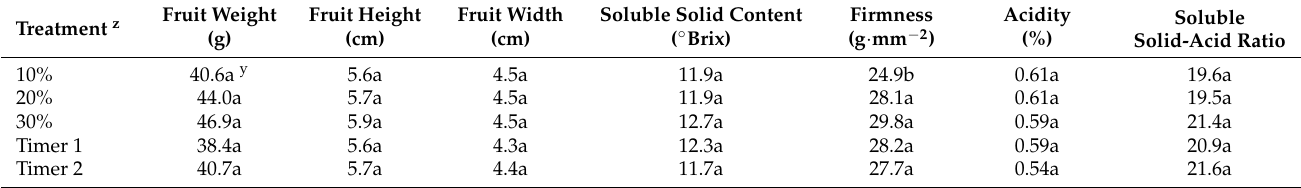
Table 3. Fruits characteristics of strawberry ‘Kuemsil’ affected by the nutrient solution supplying system using different drainage rate levels and timings.